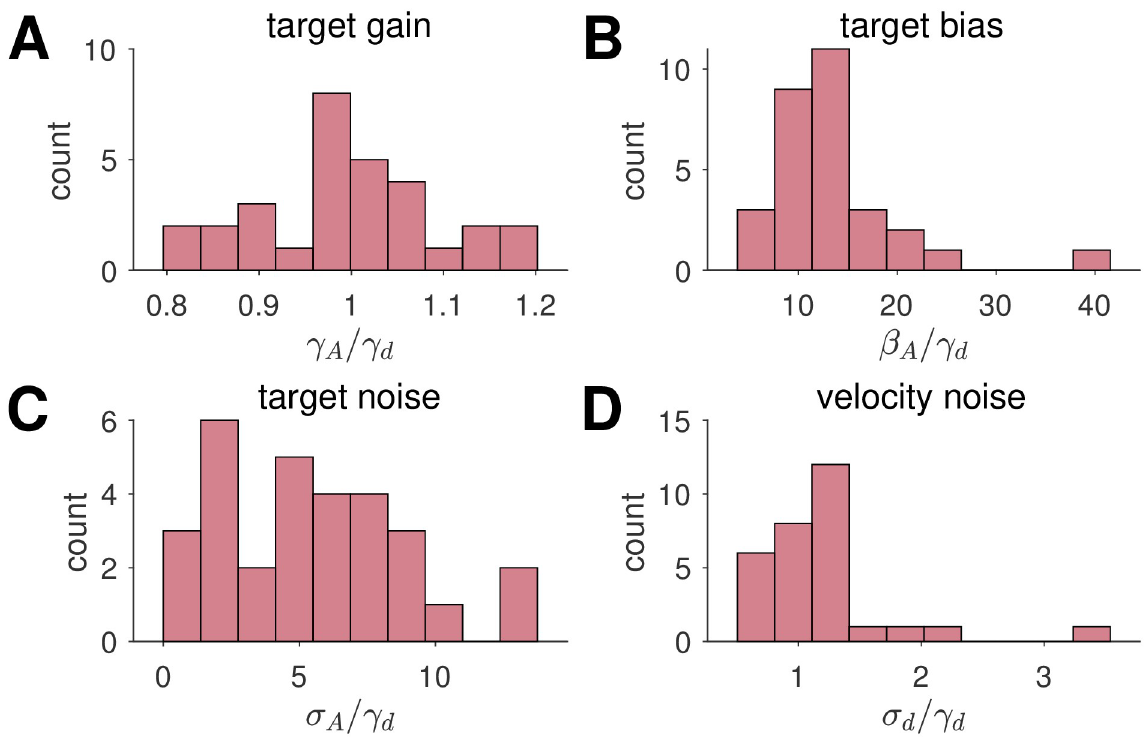
Fig 8. Parameter values for the Path Integration model fit to the No Feedback data. Histograms show the distribution parameter values across participants. The counts are the number of participants, whose fitted parameter values fall within each bin.